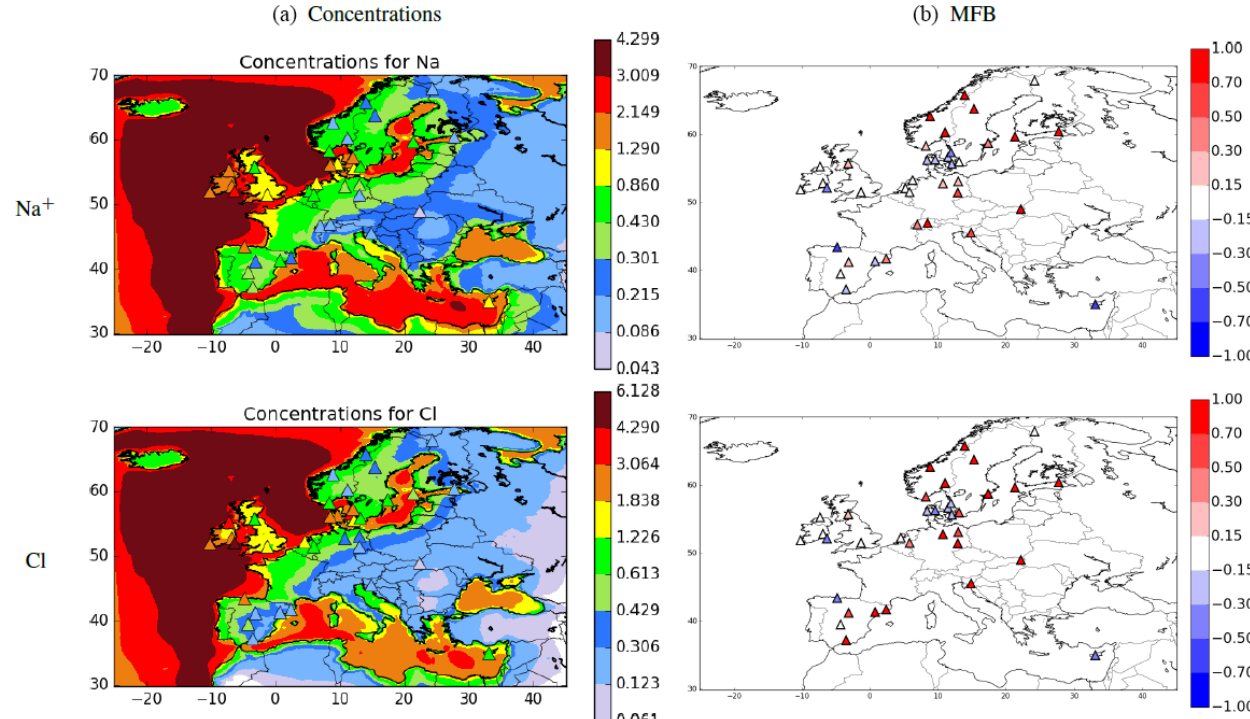
Figure 2. Modeled concentrations (in µgm − 3 ) and MFB for Na + and Cl − in 2013. Triangles correspond to measured concentrations in panel (a) and to the MFB value in panel (b)